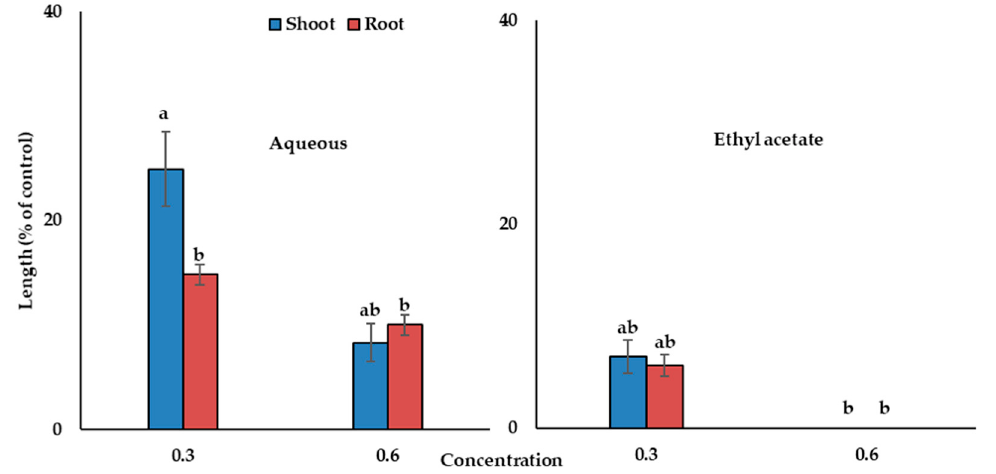
Figure 2. The phytotoxic effects on cress seedling growth of aqueous and ethyl acetate fractions obtained by the partitioning of Albizia richardiana extracts at the concentrations of 0.3 and 0.6 g DW equivalent extract/mL. The means ± standard errors for every treatment from the two separate experiments with 10 seedlings are displayed. Different letters denote the significant differences according to Tukey’s HSD test at a 0.05 probability level.